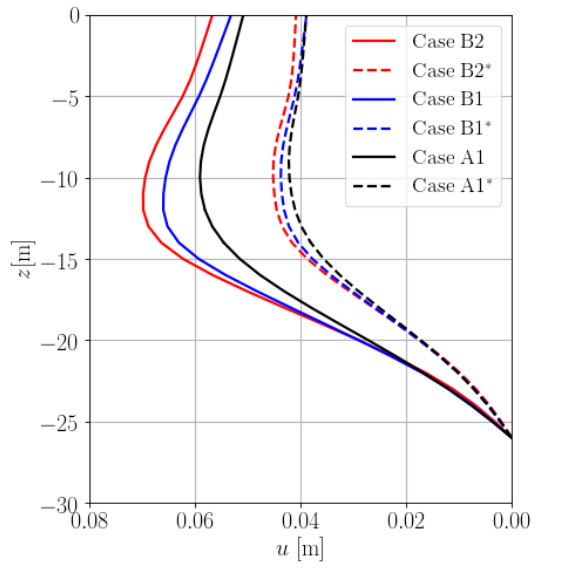
Figure 11: Comparison of wall deflections at the time instance corresponding to the last excavation step (dashed lines) (Cases A1 ∗ , B1 ∗ and B2 ∗ ) and at the time instance when the foundation raft is installed (solid lines) (Cases A1, B1 and B2).